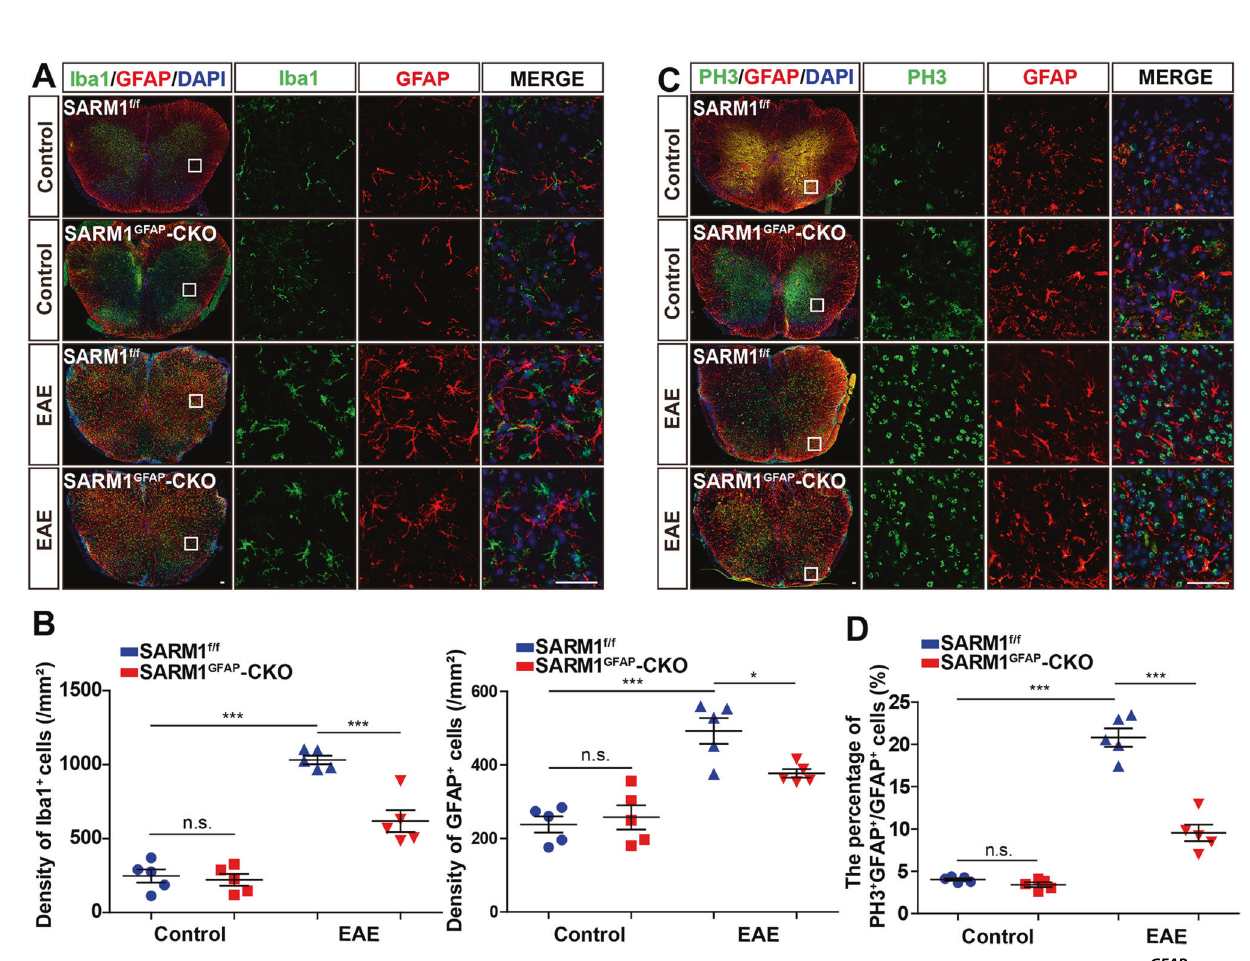
Fig. 3 The density of microglia and astrocytes, and proliferation of astrocytes were reduced in the spinal cords of SARM1 GFAP -CKO EAE mice. A Double immunostaining of Iba1 (green) and GFAP (red) in lumbar spinal cords of SARM1 f/f mice and SARM1 GFAP -CKO mice, and SARM1 f/f EAE mice and SARM1 GFAP -CKO EAE mice. B Quantitative analysis of the density of Iba1 + and GFAP + was quanti fi ed as shown in A ( n = 5). C Double immunostaining analysis of PH3 (green) and GFAP (red) in lumbar spinal cords of SARM1 f/f mice and SARM1 GFAP -CKO mice, and SARM1 f/f EAE mice and SARM1 GFAP -CKO EAE mice. D The quantitative percentage of PH3 + GFAP + cells in the total number of GFAP + cells as shown in C ( n = 5). Scale bar, 50 μ m. The data were mean ± SEM. Student ’ s t-test, n.s., not signi fi cant ( p > 0.05), * p < 0.05, *** p <